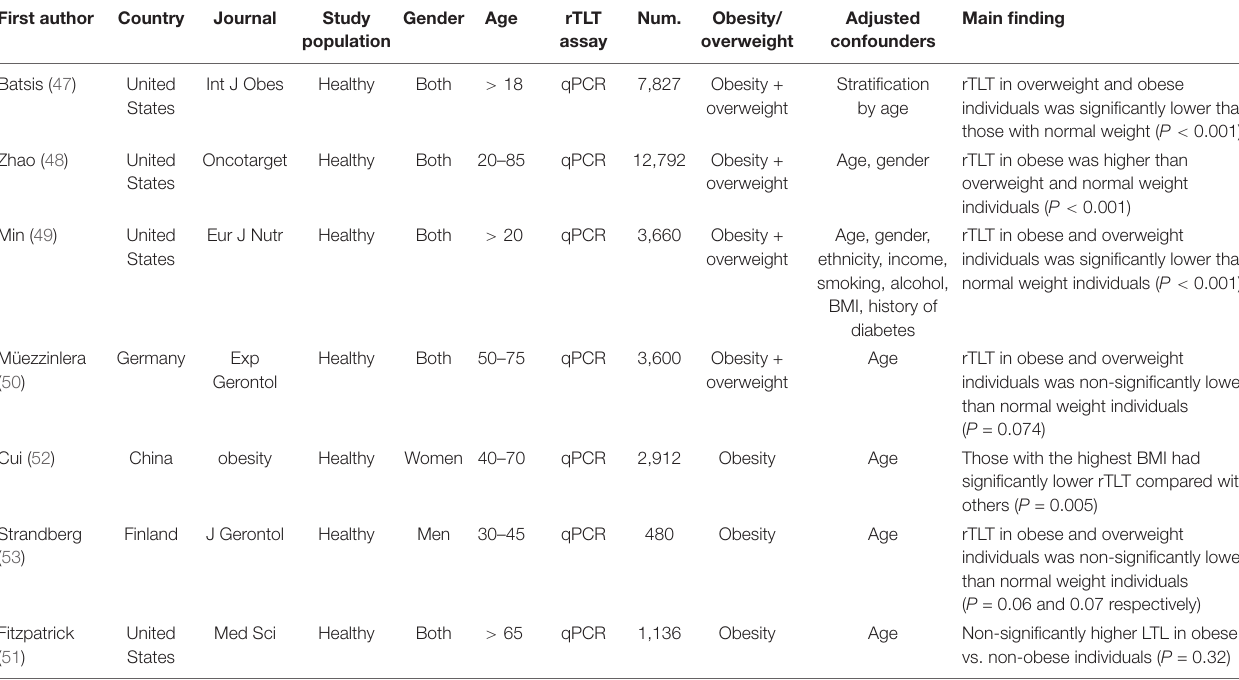
TABLE 2 | Characteristics of studies included in the systematic review owing to report the comparison of LTL between obese/overweight vs. non-obese/non-overweight